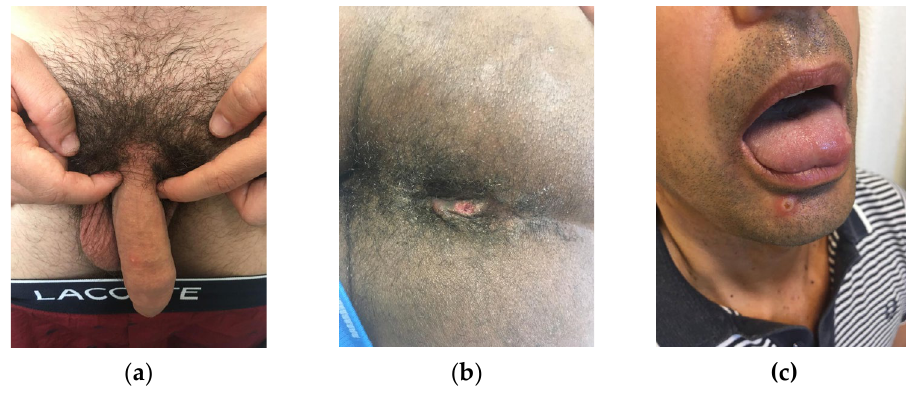
Figure 2. Genital ( a ), anal ( b ), and mucocutaneous ( c ) monkeypox lesions.